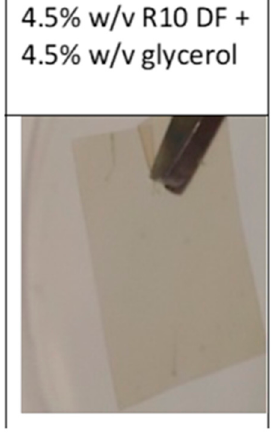
Figure 5. Films obtained using 450 mg of proteins in the presence of glycerol after the diafiltration process.